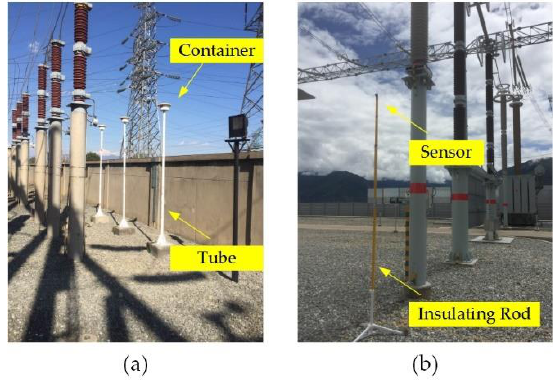
Figure 4. Field arrangement of sensors. ( a ) Field arrangement of sensors for monitoring the lightning transient voltage; ( b ) Field arrangement of sensors for measuring the switching transient voltage.